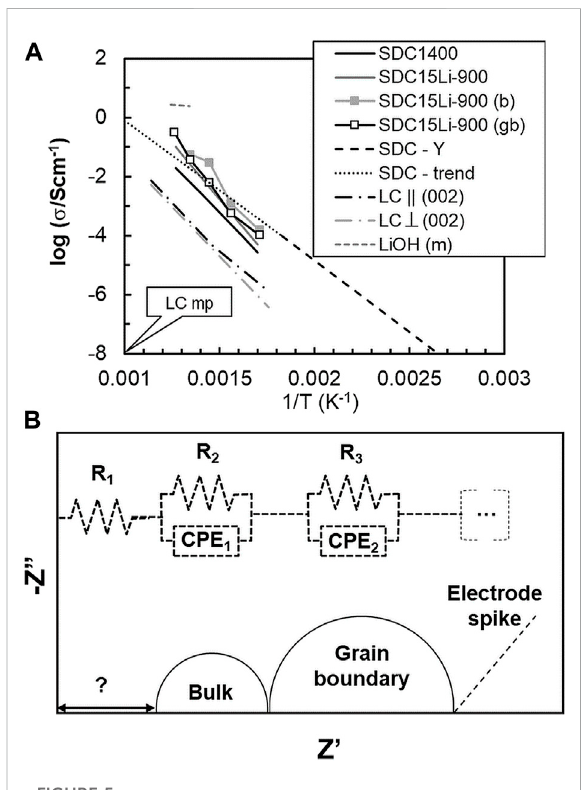
FIGURE 5 (A) Total conductivity ( σ ) versus the reciprocal of absolute temperature (1/T) of SDC without and with LiC and possible secondary phases (Claes and Glibert, 1985; Dissanayake and Mellander, 1986; Mizusaki et al., 1992; Yamashita et al., 1995; Li et al., 2012); (B) schematic drawing of the reported equivalent circuit (Li et al.,